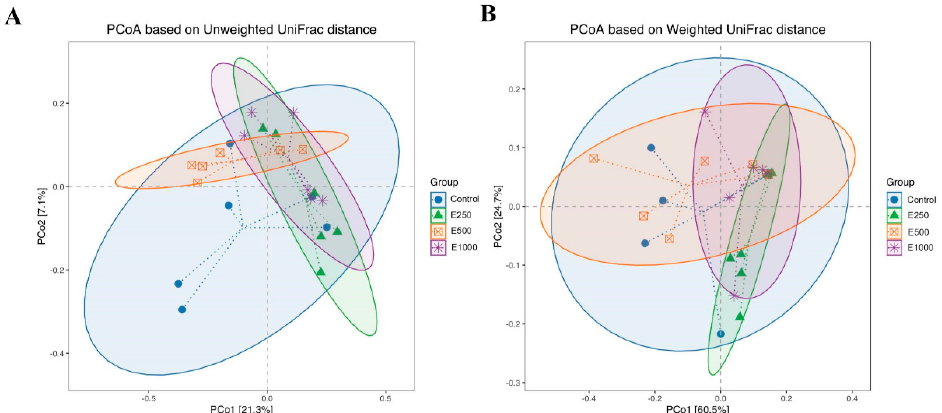
Figure 1. Principal coordinates analysis (PCoA) plot of ileal microbiota based on unweighted ( A ) and weighted ( B ) UniFrac metrics. Ileal digesta samples ( n = 6) were collected in the broilers after feeding the basal diet supplemented with 0 (Control), 250 (E250), 500 (E500), or 1000 (E1000) U glucose oxidase/kg diet for 42 days.